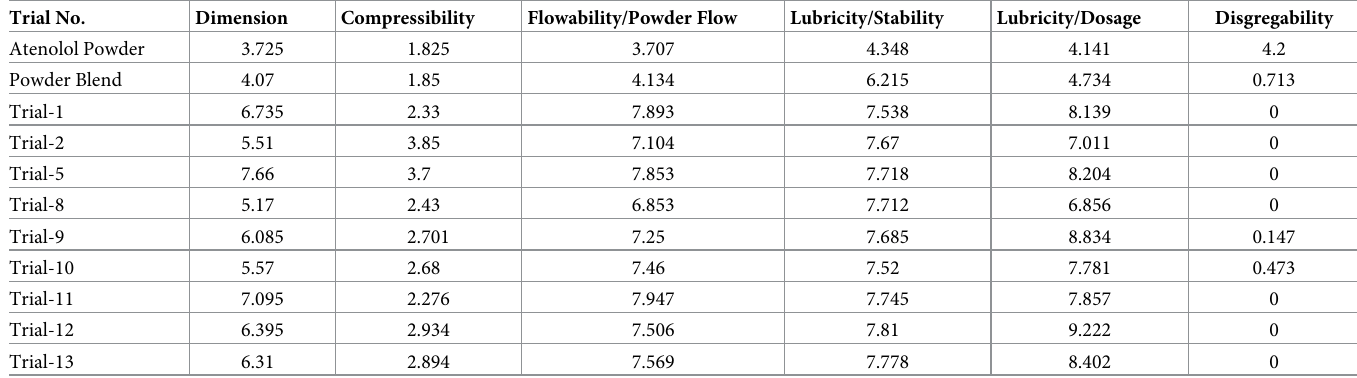
Table 6. Mean incidence values calculated for incidence factors on the basis of SeDeM-ODT expert system. Trial